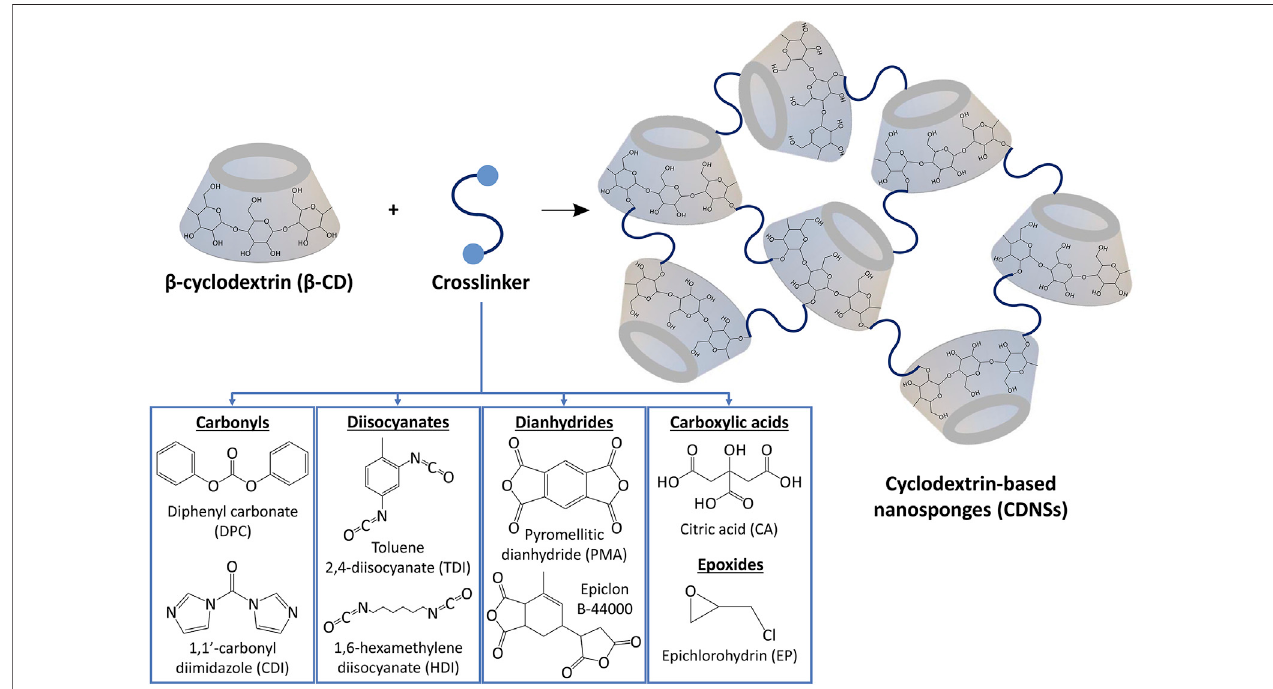
FIGURE3| SynthesisofCDNSsthroughthereactionbetween β -cyclodextrinandacrosslinker,beingcarbonyls,diisocyanates,dianhydrides,carboxylicacidsand epoxides the most common.